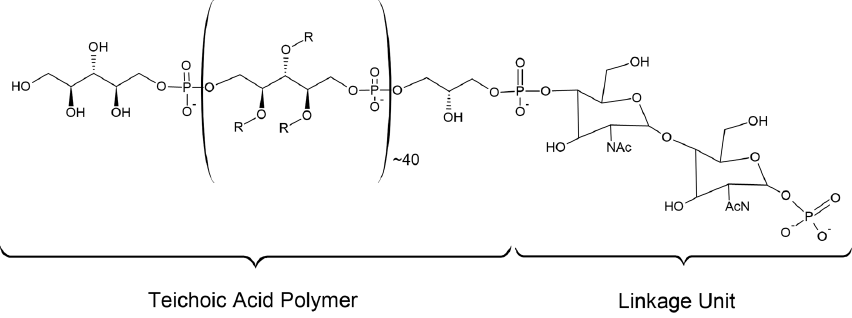
Figure 9. Structure of the cell wall teichoic acid of S. aureus . R=H, α -GlcNAc, β -GlcNAc, D-Ala.